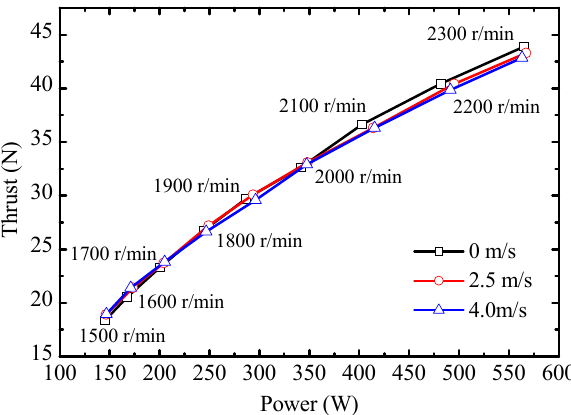
Figure 5. Thrust and power consumption in different rotational speeds.